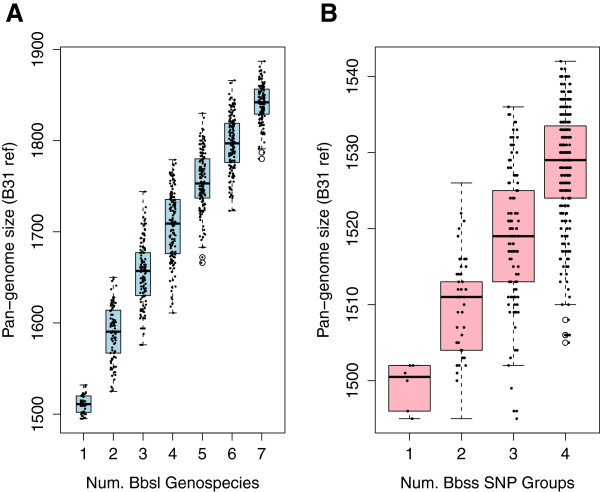
Phylogenetic prediction of future pan-genome growth. Using the same dataset as in Figure 4, the pan-genome sizes (y-axis) were re-plotted against the number of distinct phylogenetic groups (x-axis) these genomes represent, another phylogeny-guided way to linearize the prediction of pan-genome sizes. (A) Each point represents the pan-genome size (y-axis) of a group of randomly selected genomes. The number of distinct B. burgdorferi s.l. species these genomes represent is plotted on x-axis. Based on the linearity of the median values, we estimate that sequencing an additional species would yield ~100 new genes. (B) Each point represents the pan-genome size (y-axis) of a group of randomly selected genomes. The number of distinct B. burgdorferi s.s. SNP groups these genomes represent is plotted on x-axis. Predicted increase of the B. burgdorferi s.s. pan-genome with increasing number of SNP groups. Based on the linear median values, we estimate that sequencing an additional new SNP group (e.g., a European lineage) would yield merely ~10 new genes.